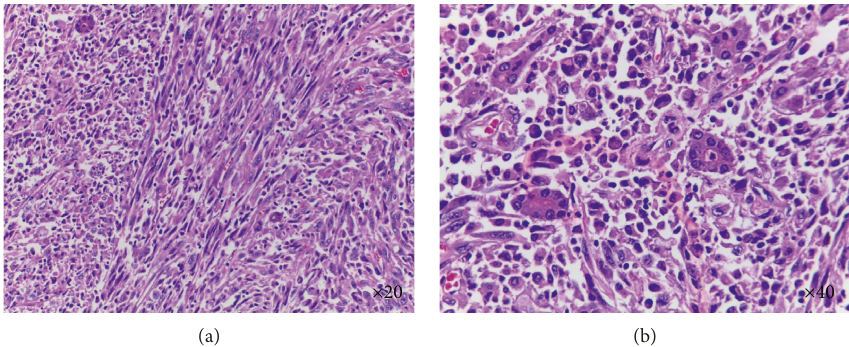
Figure 2: Histological appearance of the tumor showed malignant spindle cell (H&E